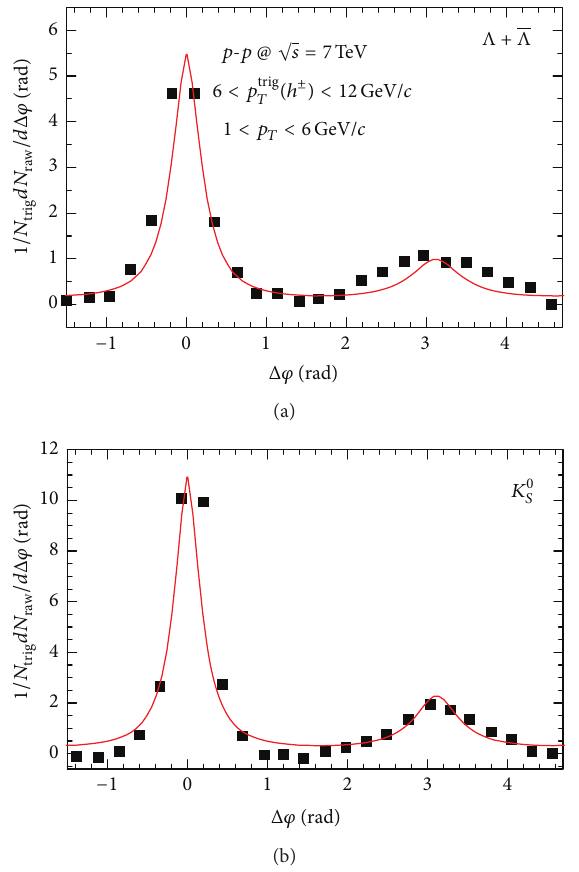
Figure 7: The baseline-subtracted two-particle correlations as a function of Δ𝜑 for ℎ ± − 𝐾 0 𝑆 and ℎ ± − (Λ + Λ) correlations in p - p = 7 TeV. The symbols denote the experimental collisions at √𝑠 NN data of the ALICE Collaboration at the LHC [17], and the lines are the modeling